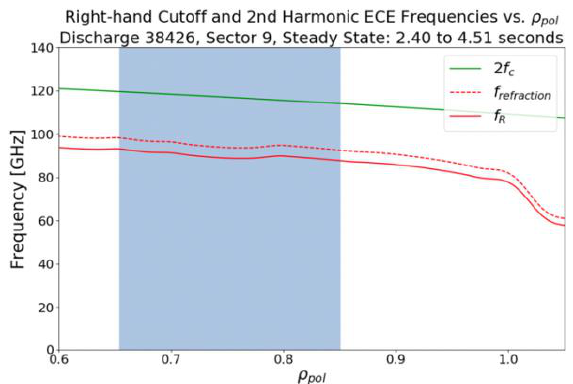
Fig. 3. CECE measurement locations (highlighted region) are not cutoff if the second harmonic electron cyclotron frequency (solid green curve) is above the right-hand cutoff frequency (solid red curve). Additionally, the effects of refraction on data processed by the automated analysis are minimized by identifying and removing from further analysis any CECE channels that have second harmonic electron cyclotron frequencies below a 105.5% multiple of the right-hand cutoff frequency (dashed red curve) [19-21].